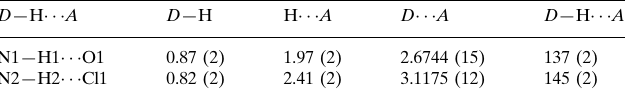
Rigaku Saturn diffractometer Absorption correction: multi-scan ( CrystalClear ; Rigaku/MSC, 2005)